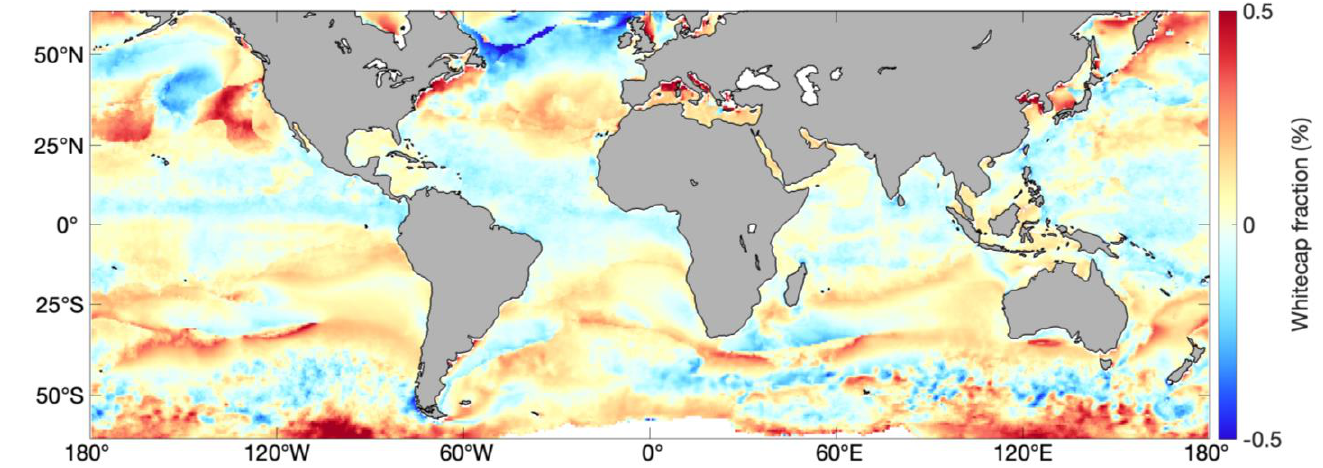
Figure 7. The bias of W values calculated by thee NN-W and A16 in October